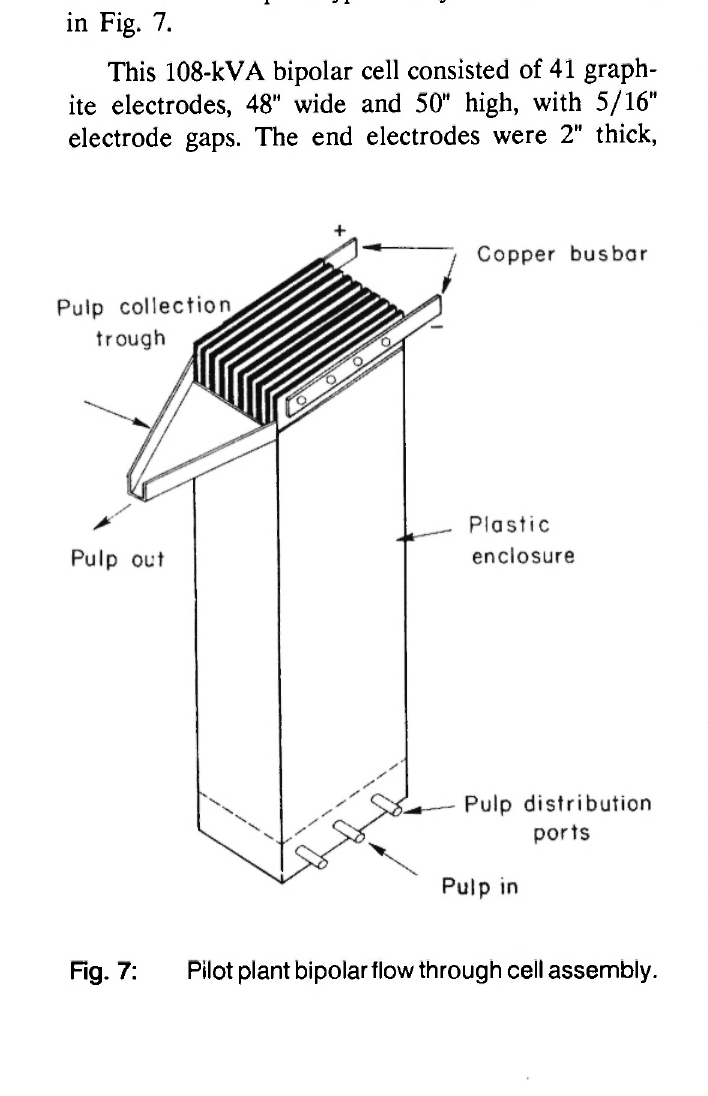
Fig. 7: Pilot plant bipolar flow through cell